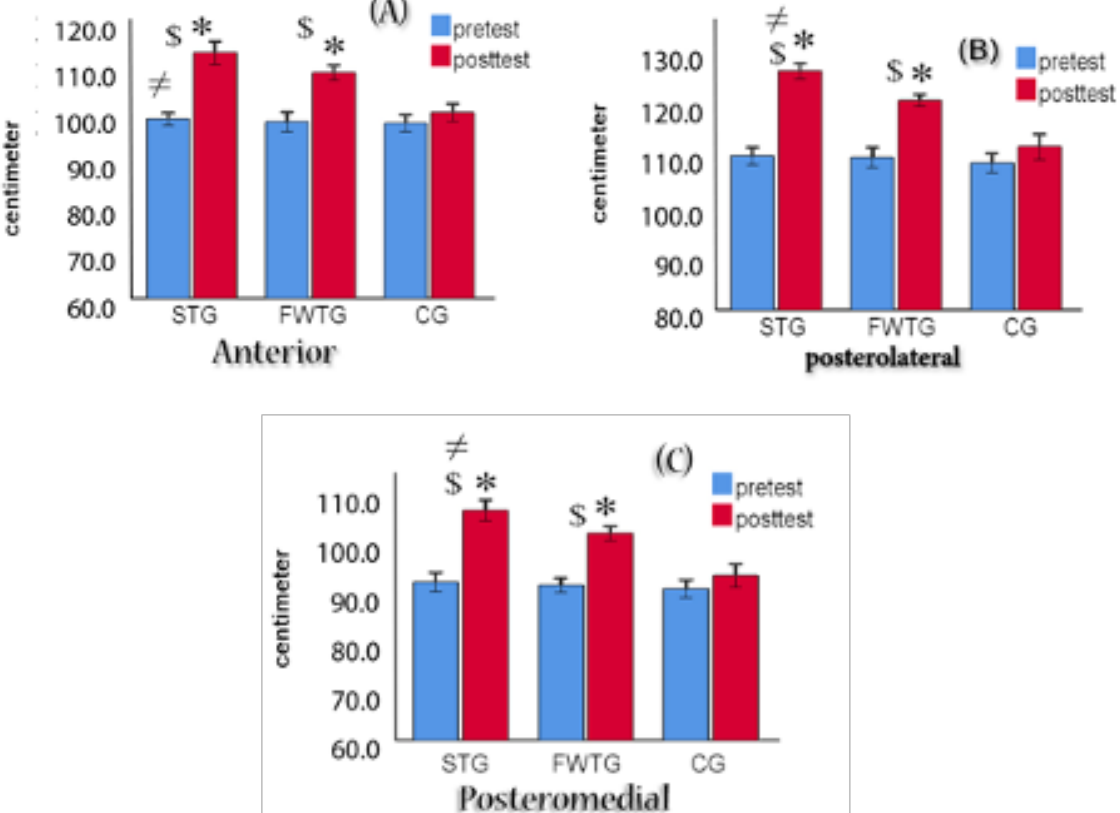
Figure 4. The effects of training intervention on YBT in the three directions; anterior (A), posteromedial (B), and posterolateral (C). *significant difference from pre-test, $ significant difference from the CG. ≠ significant difference from the FWTG. P value set at